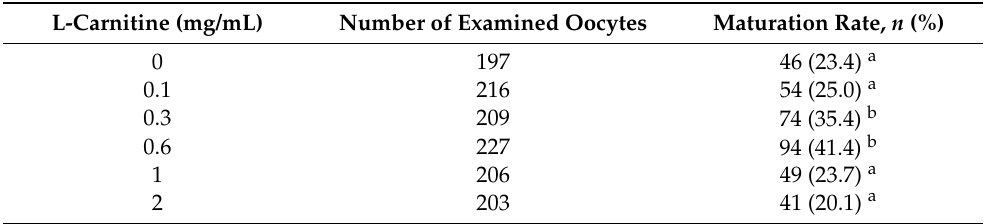
Table 1. Effects of L-Carnitine supplementation during in vitro maturation (IVM) on nuclear matura- tion rates of canine oocytes ( n = 3).